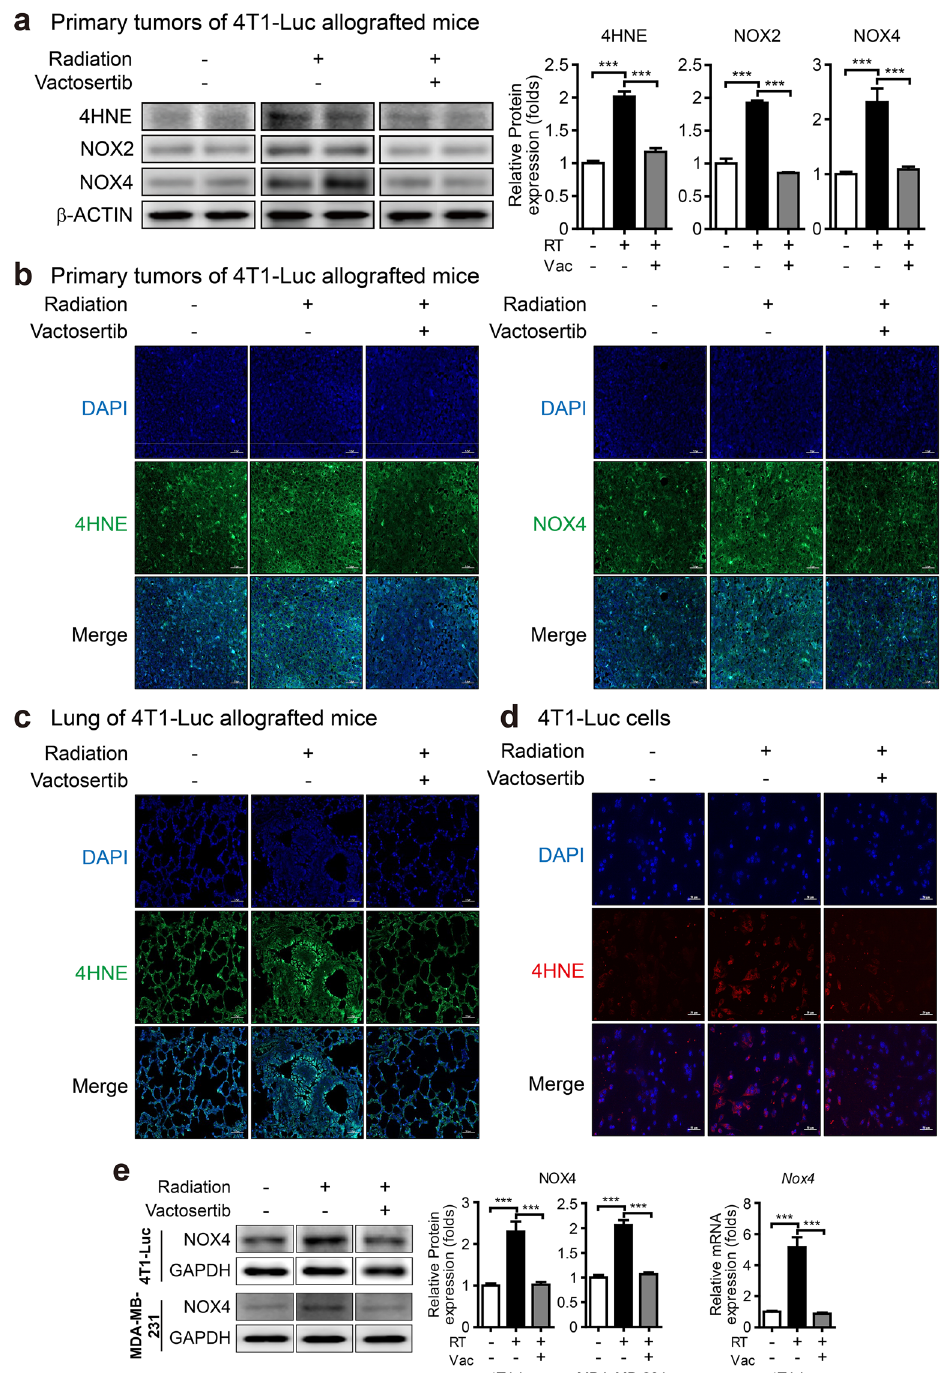
Figure 3. Vactosertib suppresses lipid peroxidation and NADPH oxidases (NOXes). ( a ) Protein expression of 4-HNE, NOX2, NOX4 in irradiated primary tumors of mice with or without co-treatment with vactosertib (Band was normalized by β-ACTIN.). Original blots are presented in Supplementary Fig. 2. ( b, c ) Fluorescence immunohistochemistry analysis of 4-HNE and NOX4 in irradiated primary tumors ( b ) and 4-HNE in the lung ( c ). Expression of 4-HNE and NOX4 was shown by green fluorescence image (× 20, scale bar: 50 μm). ( d ) Immunofluorescence staining of 4-HNE in irradiated 4T1-Luc cells. Expression of 4-HNE was shown by red fluorescence image (× 20, scale bar: 50 μm). ( e ) Protein expression of NOX4 in 4T1-Luc and MDA-MB-231 cells by western blot analysis (Band was normalized by GAPDH.). The right graph shows the relative intensity of mRNA expression of Nox4 in 4T1-Luc cells. The band image was cropped after selecting a representative blot, and the sample was derived from the same experiment. Original blots are presented in Supplementary Fig.